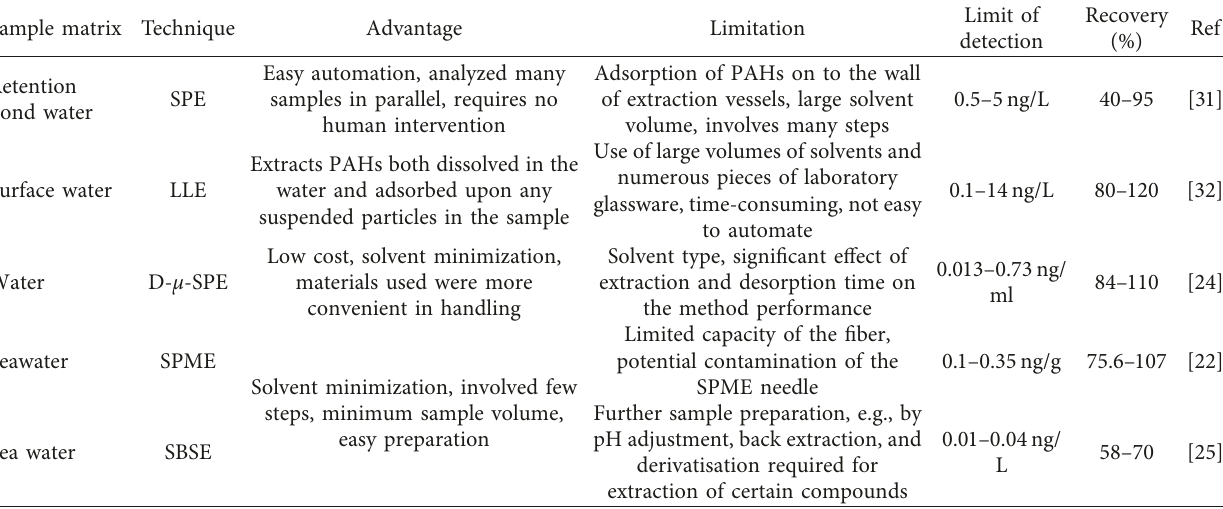
Figure 2: Sources and routes of exposure of PAHs to human. Table 4: Some PAHs extraction